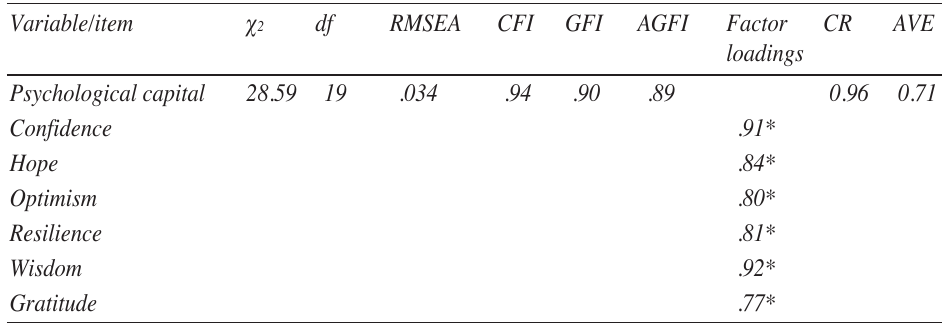
Table 3: Results for Confirmatory Factor Analysis of Study Variables